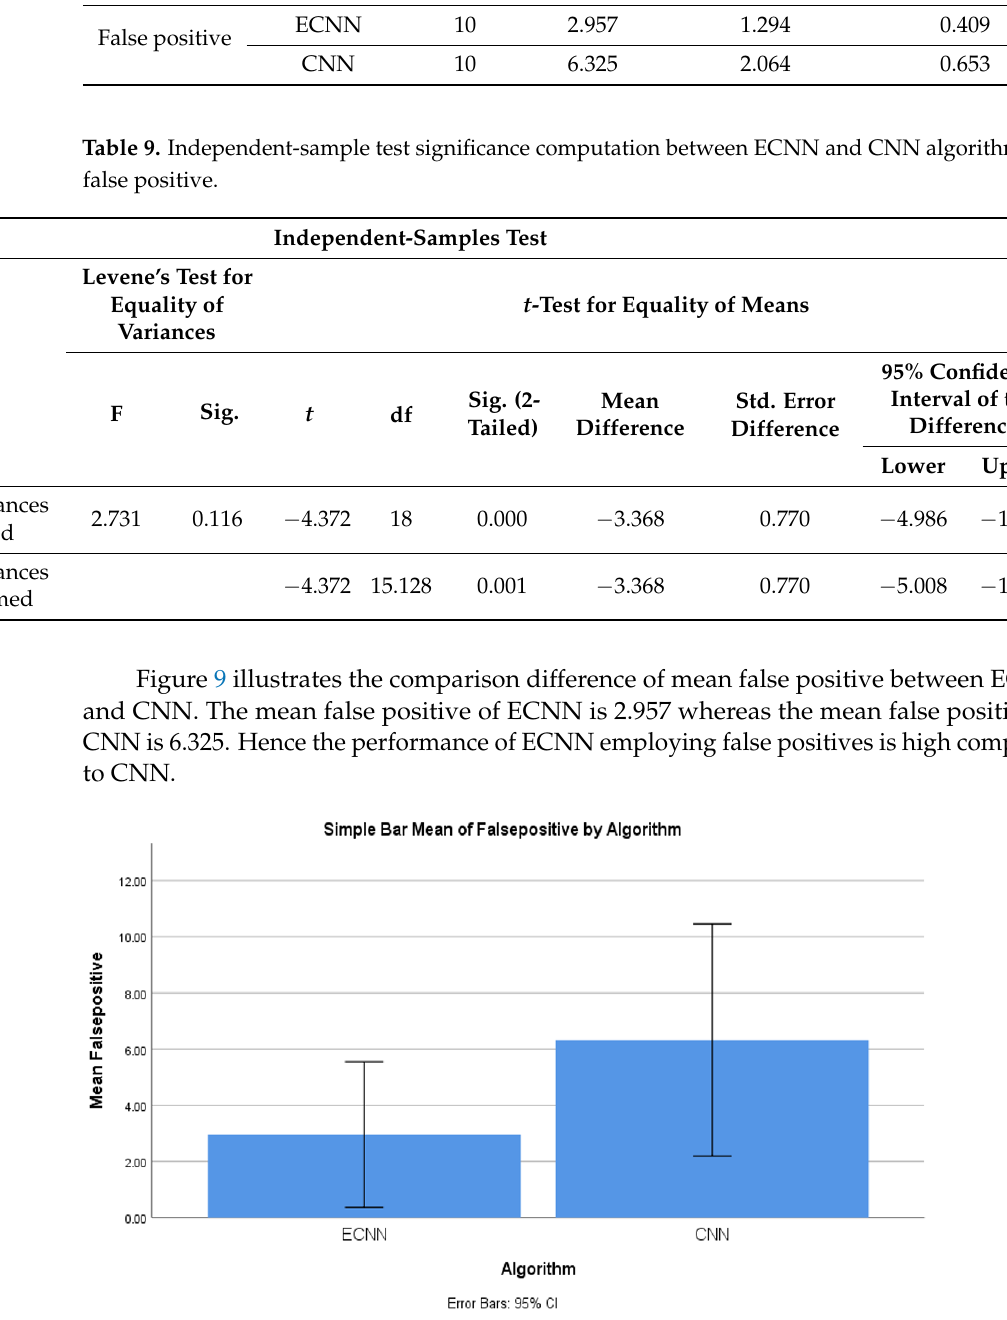
Table 8. Group statistics parameter comparison for false positive between ECNN and CNN.